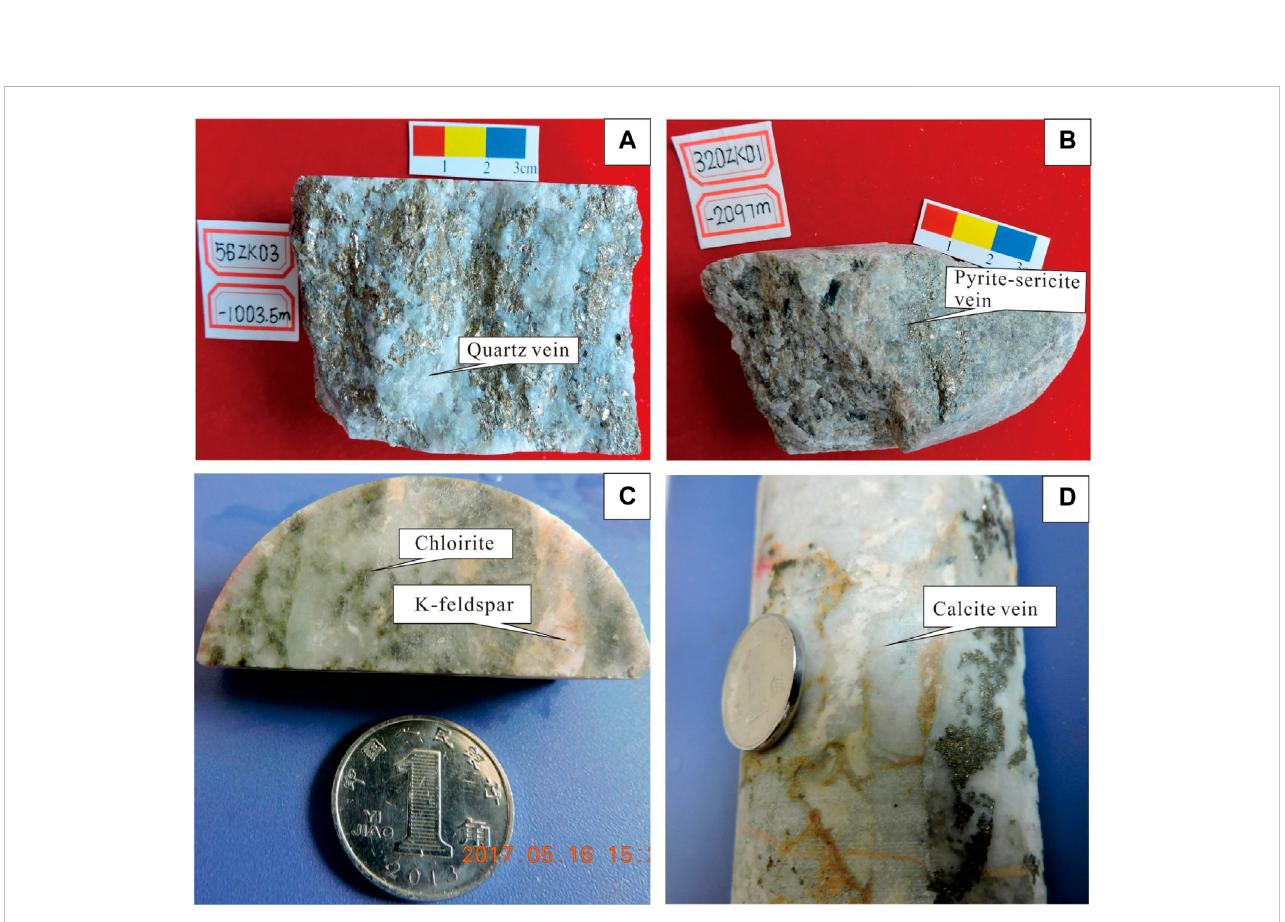
FIGURE 4 Photos of wallrock alteration at the Zhaoxian gold deposit ( (A) . Silici fi cation; (B) . Pyrite-sericite alteration; (C) . Chloritization, K-feldspar alteration; (D) . Carbonate alteration).